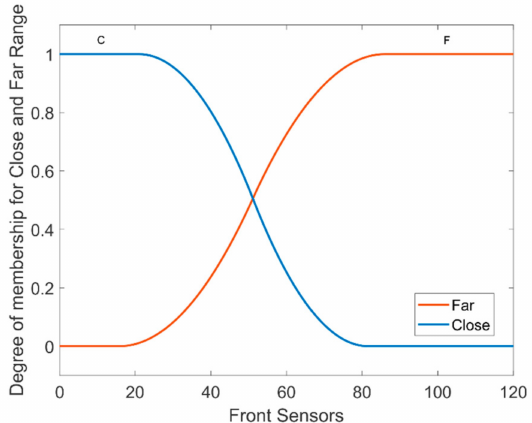
Figure 11. Input membership function for the ultrasonic sensor readings fuzzification.